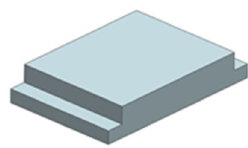
Figure 8. Three-dimensional model of the